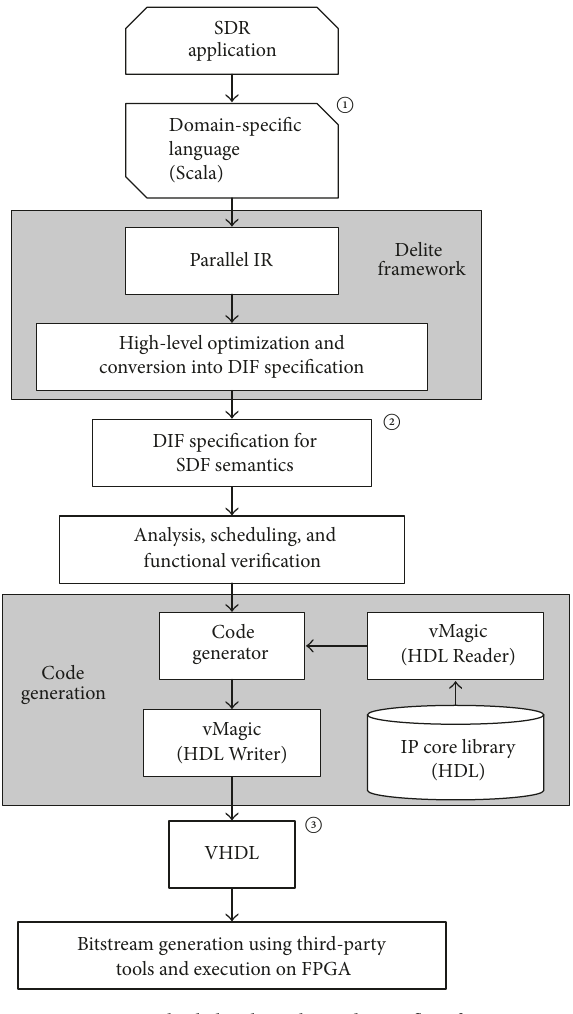
Figure 30: A high-level synthesis design flow for SDR.